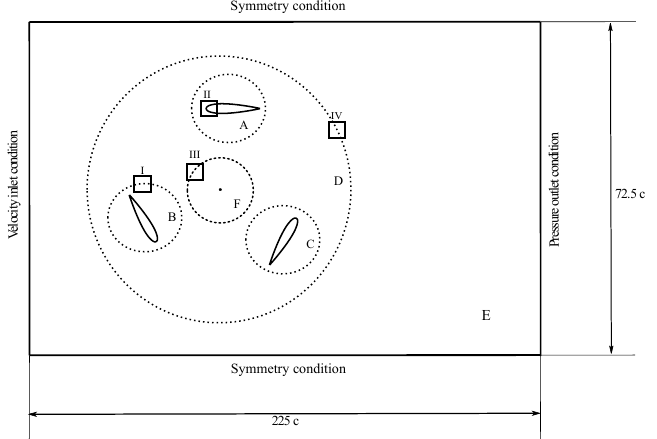
Figure 9. Layout of the computational domain (not at scale). Rotating regions: ( A – D ); fixed regions: ( E , F ); dot: interfaces between domains; square: details of computational